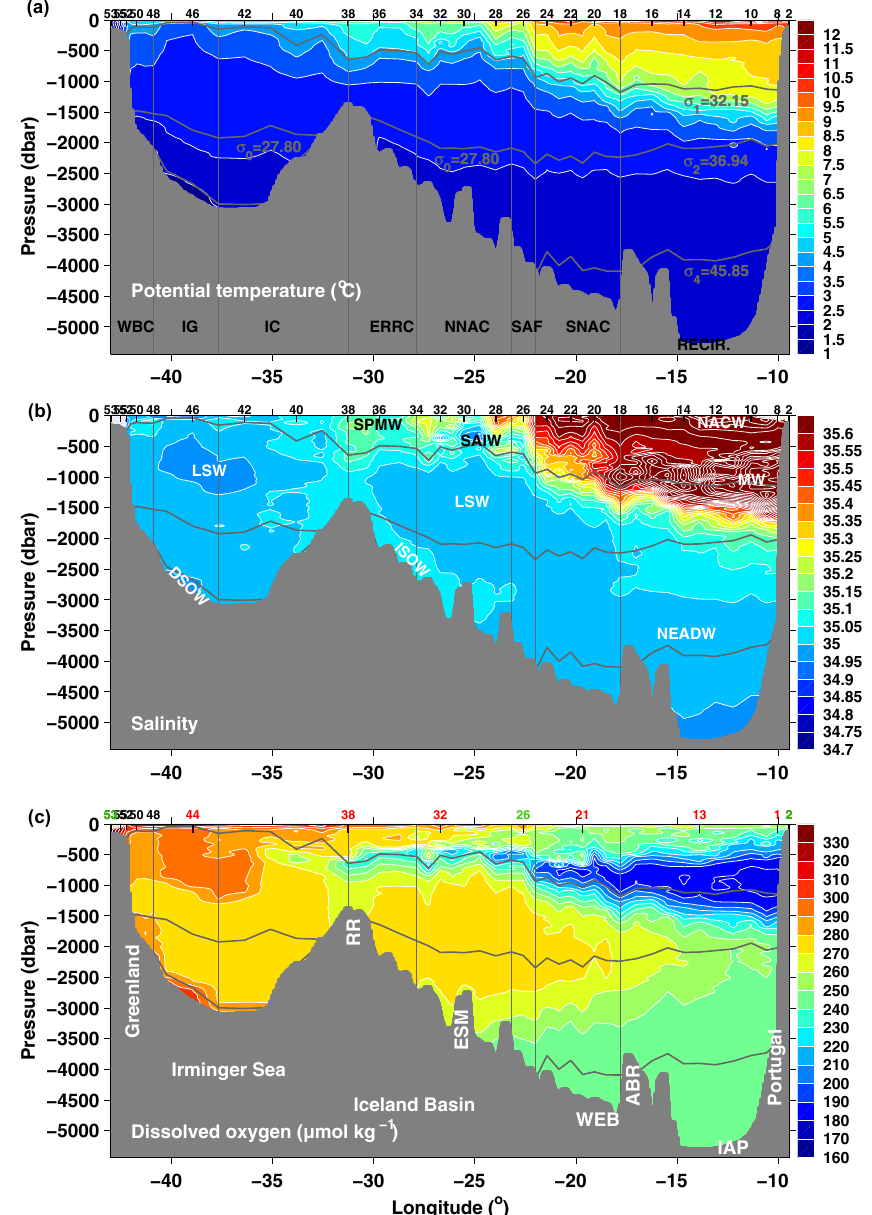
Figure 2. Vertical section of potential temperature ( ◦ C), salinity, and oxygen (µmolkg − 1 ) along the OVIDE section measured during the GEOVIDE cruise. The horizontal gray lines in the three plots represent the isopycnal layers ( σ 1 = 32.15, σ 0 = 27.80kgm − 3 or σ 2 = 36.94, σ 4 = 45.85kgm − 3 ) indicated in panel ( a ). The vertical gray lines in the three plots are the limits between the different circulation components crossing the OVIDE section: Western Boundary Current (WBC), Irminger Gyre (IG), Irminger Current (IC), Eastern Reykjanes Ridge Current (ERRC), northern branch of the North Atlantic Current (NNAC), Subarctic Front (SAF), southern branch of the North Atlantic Current (SNAC), and the recirculation in the Iberian Abyssal Plain (RECIR). The main water masses are indicated in panel ( b ): Denmark Strait Overflow Water (DSOW), Iceland–Scotland Overflow Water (ISOW), Labrador Sea Water (LSW), subpolar mode water (SPMW), Subarctic Intermediate Water (SAIW), North Atlantic Central Water (NACW), Mediterranean Water (MW), and Northeast Atlantic Deep Water (NEADW). The main topographic features are indicated in panel ( c ): Reykjanes Ridge (RR), Eriador Seamount (ESM), Western European Basin (WEB), Azores–Biscay Rise (ABR), and Iberian Abyssal Plain (ABP). Ticks at the top of panels ( a ) and ( b ) indicate the positions of all the stations measured during GEOVIDE along the OVIDE section, with station numbers given above. In panel ( c ), the red and green numbers indicate the position of the super stations and XL stations,